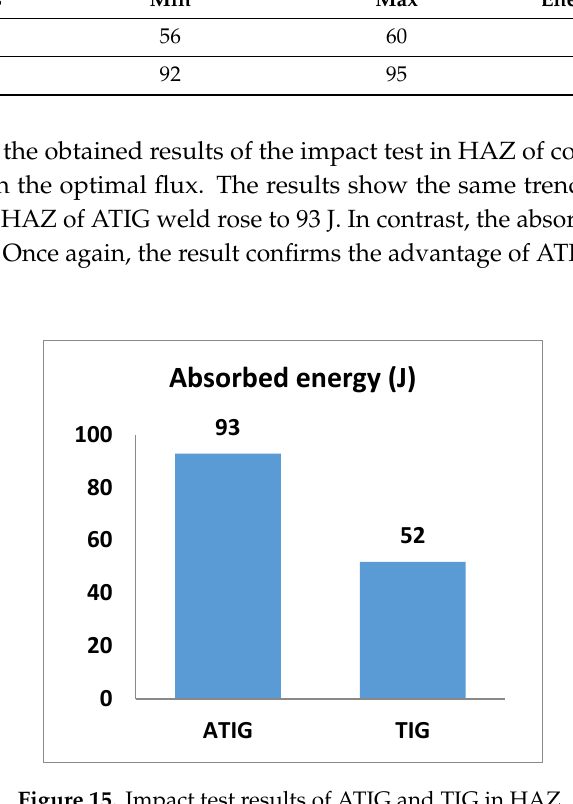
Table 9. Mesurments of energy absorbed and standards deviation of TIG and ATIG (optimal flux) at fusion zone.